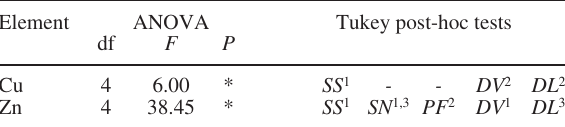
Table 4. – Inter-specific variation of trace metal concentration in muscle of juveniles. Results of ANOVA comparisons and respec- tive Tukey post-hoc multiple comparisons tests for Cu and Zn con- centrations in muscle of juveniles of five fish species ( SS , Solea solea ; SN , Solea senegalensis ; PF , Platichthys flesus ; DV , Diplodus vulgaris; and DL , Dicentrarchus labrax ) collected in eight estuar- ies along the Portuguese coast (Douro, Ria de Aveiro, Mondego, Tejo, Sado, Mira, Ria Formosa and Guadiana). * P <0.05; ns , non- significant; different numbers (superscript) represent significant differences among species at P <0.05 in Tukey post-hoc tests.